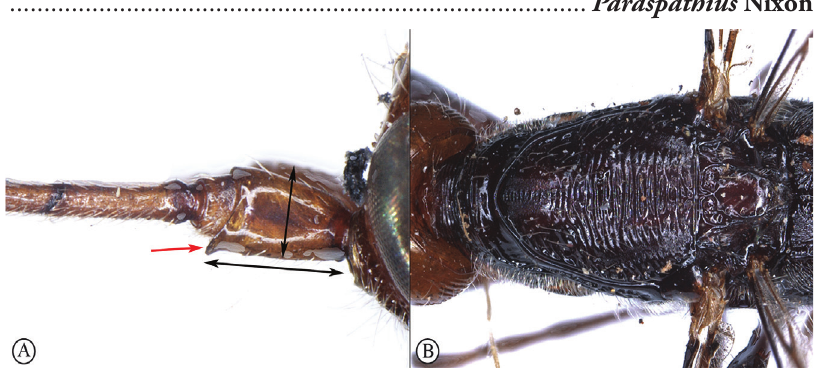
Scape of antenna long, about 2.0× as long as wide with distinct projection on the ventral apical margin in lateral view (A). Notauli absent (B) ...................